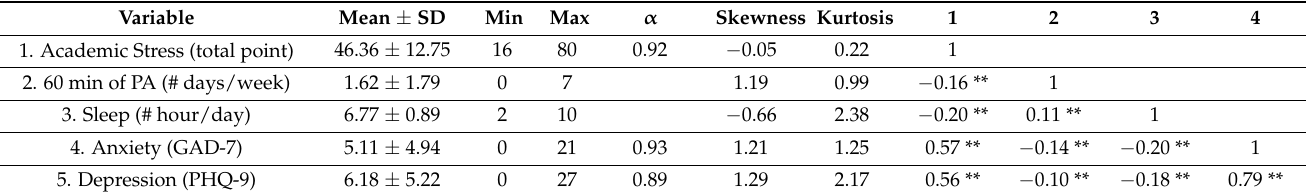
Table 2. Mean and correlation of academic stress, physical activity, sleep, anxiety and depression.